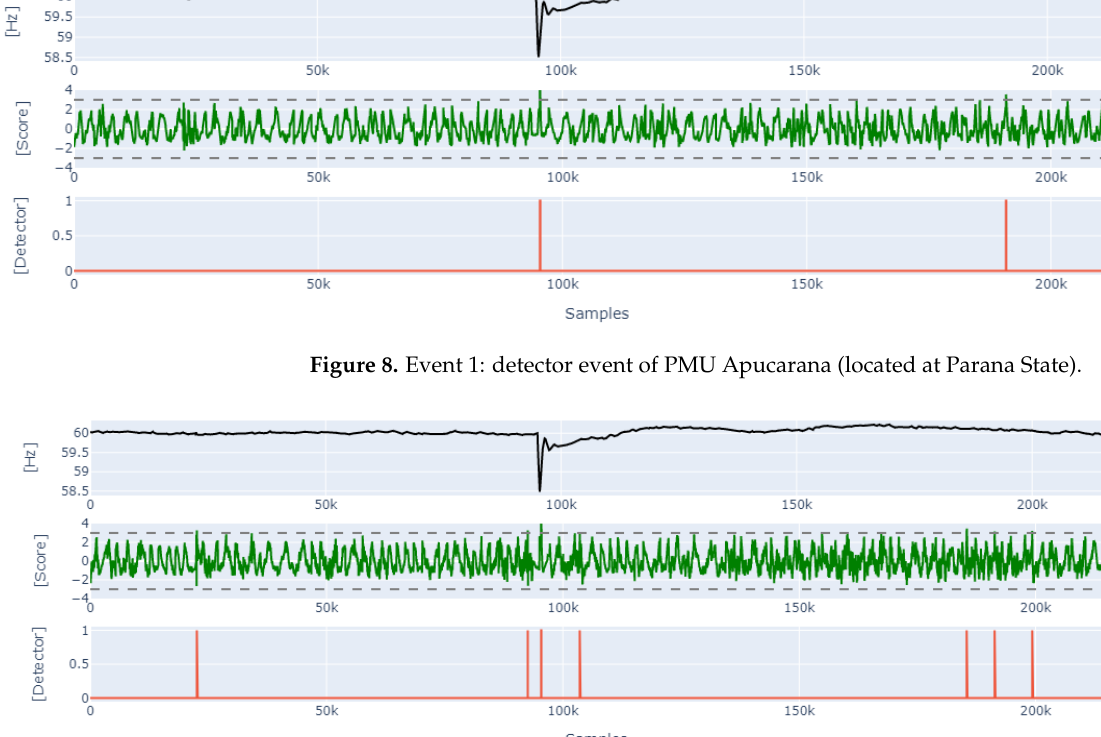
Figure 8. Event 1: detector event of PMU Apucarana (located at Parana State).